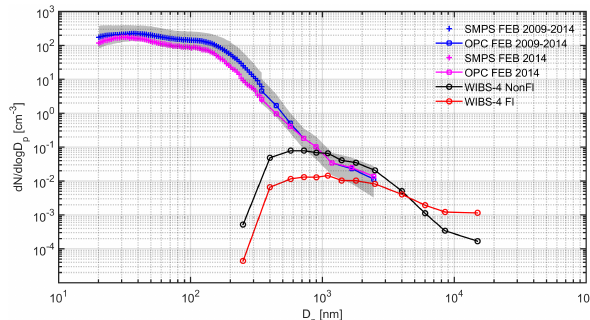
Figure 4. Comparison of long-term median SMPS and OPC number–size distribution measurements made during Febru- ary 2009 to 2014 to those made during the 2014 campaign. Grey shaded area represents the quartiles of the long-term